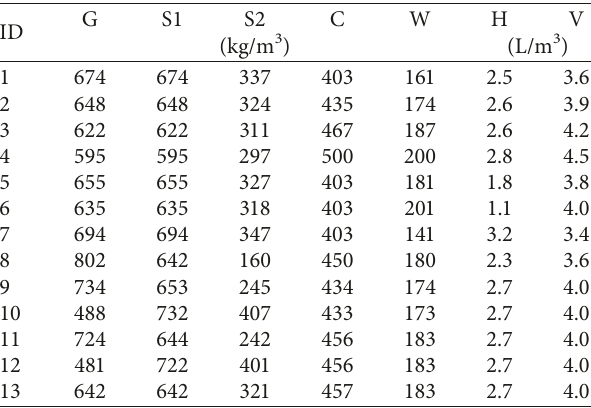
Table 2: Mixture proportions.